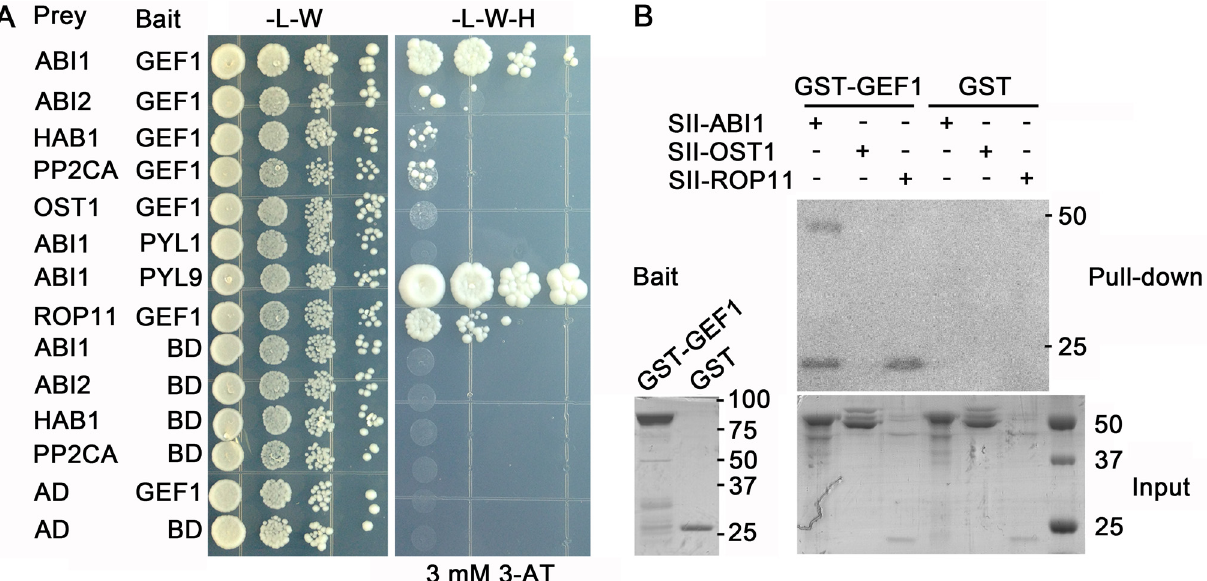
Fig 4. GEF1 directly interacts with Arabidopsis type 2C protein phosphatase ABI1. (A) Yeast-two-hybrid (Y2H) assay of interactions of GEF1 with the indicated PP2Cs. The indicated construct combinations were co-transformed into the yeast strain pJ69-4A. Transformants were grown on -L-W control plates (left) for 3 d and -L-W-H (lacking Leucine, Tryptophan, and Histidine) selective plates with 3 mM 3-amino- 1,2,4-triazole (3-AT) (right) for 6 d. The interactions of ABI1/PYL9 and ROP11/GEF1 were used as positive controls, and ABI1/PYL1 without ABA as negative control. (B) In vitro binding assay of GEF1 and ABI1. Each input protein was incubated with Glutathione Sepharose beads containing GST-GEF1 or GST control protein, followed by GST-GEF1 and GST affinity purification and subsequent immunoblotting with anti- Strep-II antibody. Bait (left): Coomassie brilliant blue staining of purified bait protein GST-GEF1 and GST; Pull-down: western blot of pull-down with Gluothathione Sepharose and probed with anti-Strep-II antibody; Input: Coomassie brilliant blue staining of recombinant input proteins StrepII-ABI1, StrepII-OST1, and StrepII-ROP11. ROP11/GEF1 and OST1/GEF1 binding were used as positive and negative controls, respectively.